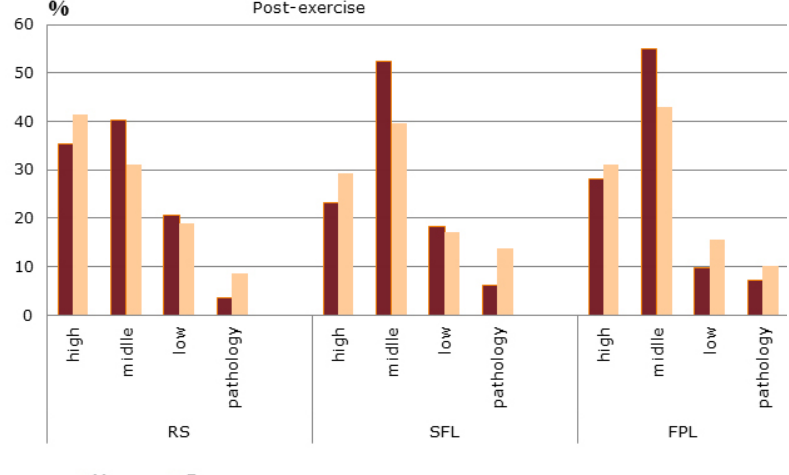
Fig. 1. CNS activation levels in female (n=58) and male (n=82) students with high physical activity at relative rest